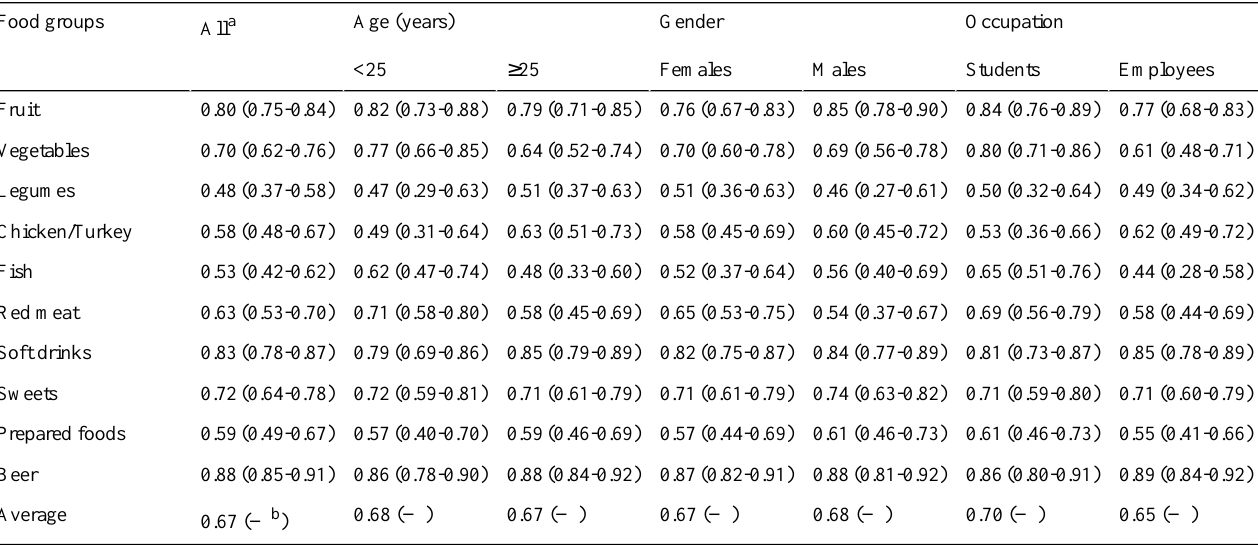
Table 2. Spearman correlation coefficients derived from the electronic 12-hour dietary recall app versus the food frequency questionnaire for categories of food group consumption and strata: age (years): <25 and ≥ 25; gender: females and males; and occupation: students and employees. Comparison of the electronic 12-hour dietary recall app versus food frequency questionnaire. Spearman correlation coefficients (95% CI).